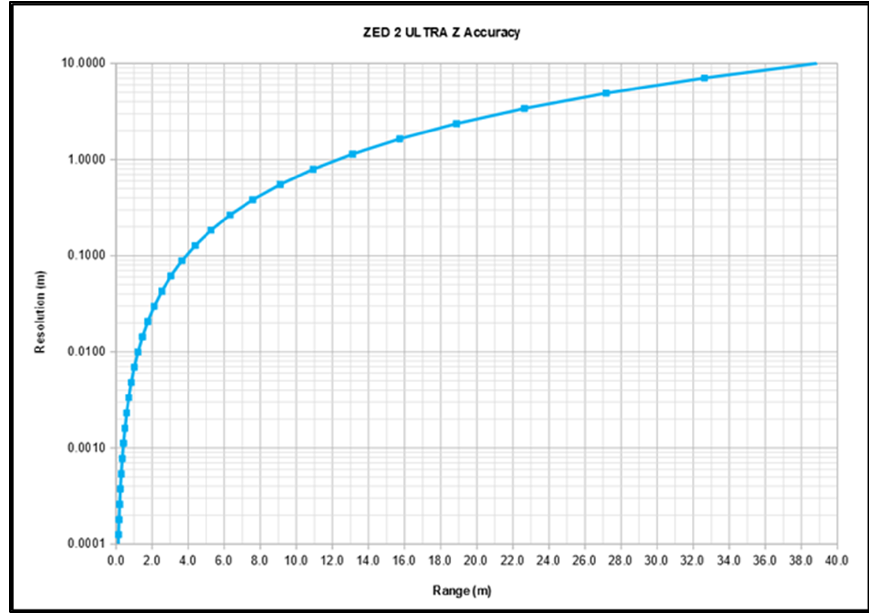
Figure 2. The accuracy graph of the ZED 2i depth sensor (courtesy of Stereolabs) [36].